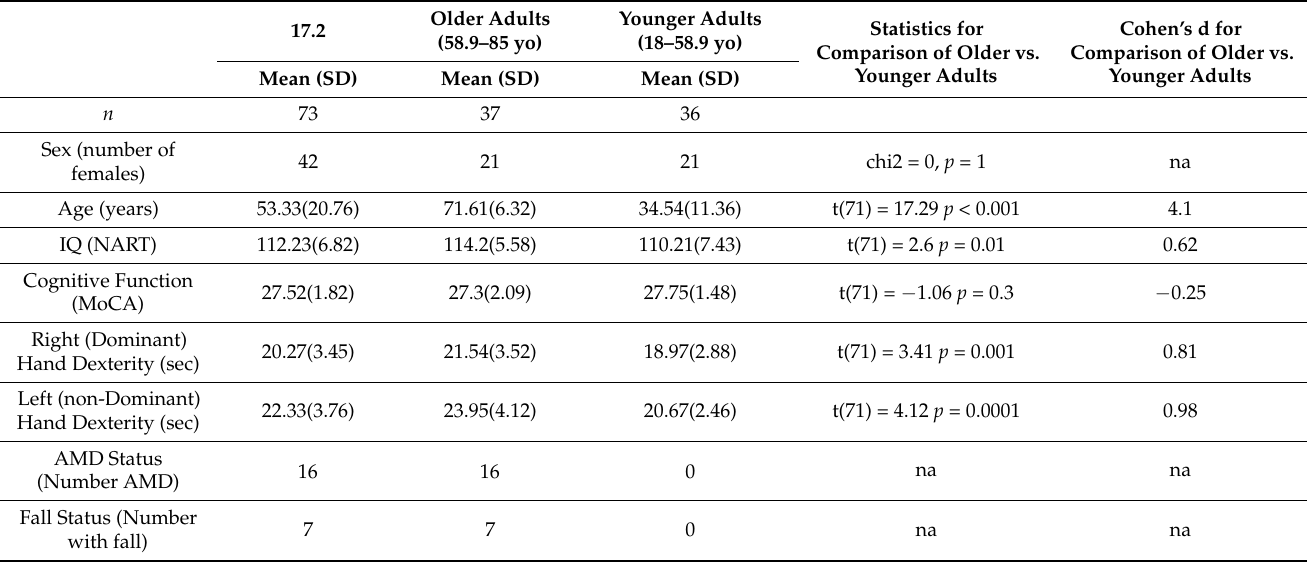
Table 1. Demographics information across all participants and between age